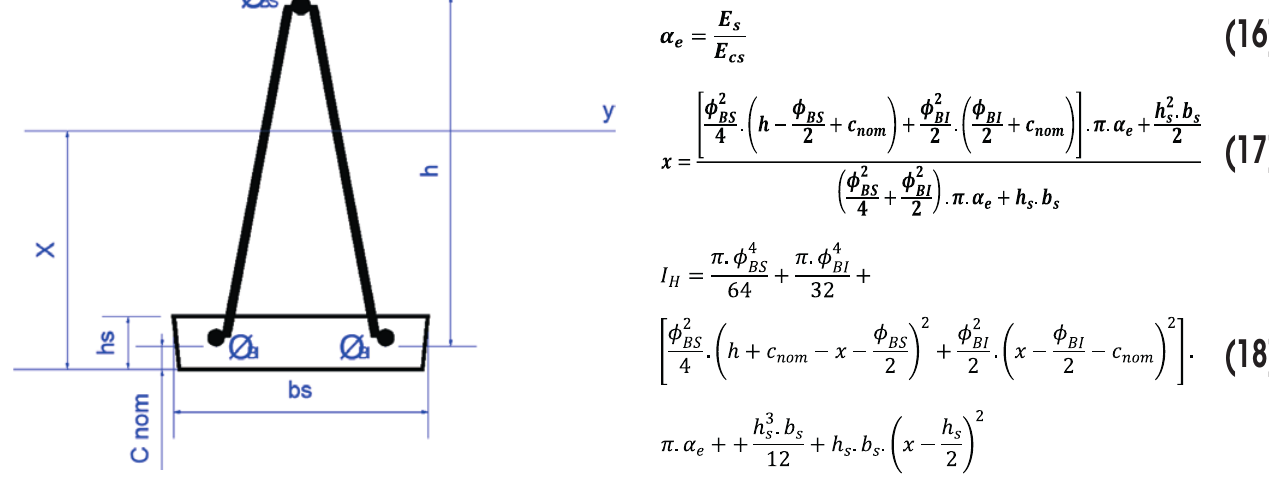
The parameters indicated in Equations 16 and 18 are shown in Figure 12: x is the distance from the center of gravity position (of the transformed cross section) to the bottom face of the